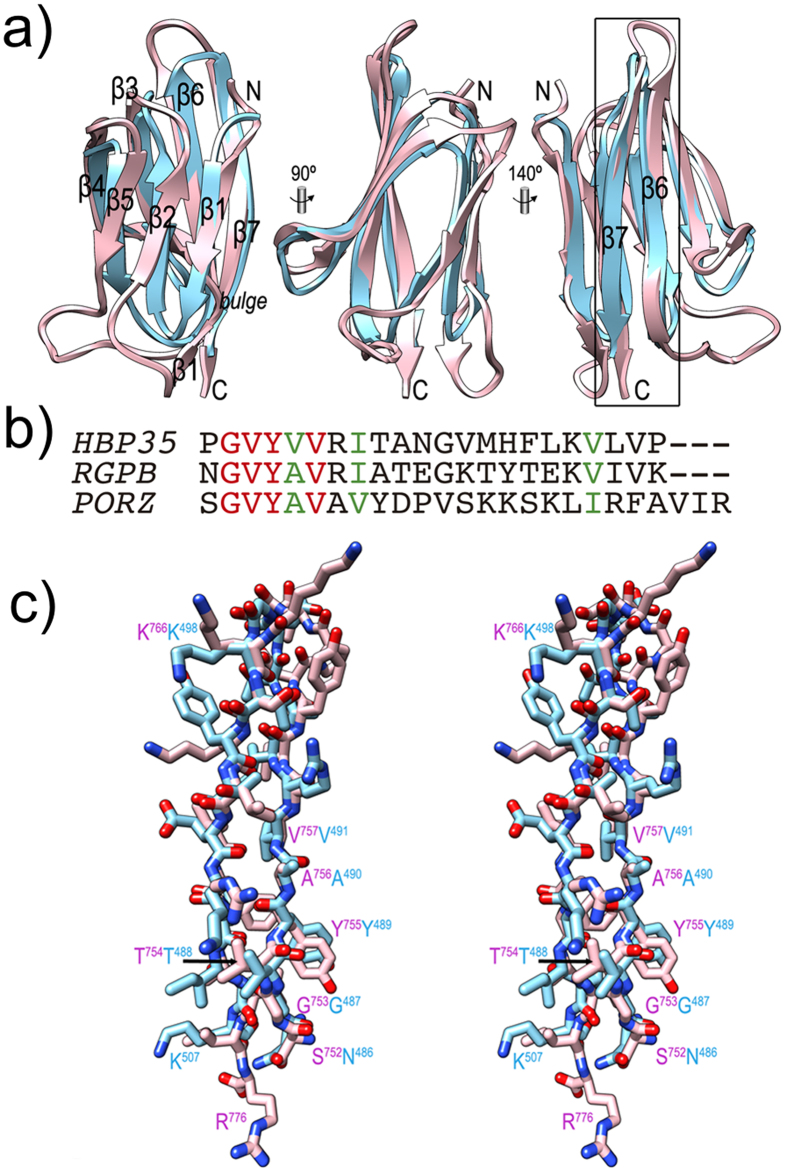
The C-terminal domain of PorZ.(a) Ribbon-plot of the CTDs of PorZ (pink) and RgpB (cyan) after optimal superposition facing the three-stranded front β-sheet (left, the seven constituting strands are labelled, see also Fig. 5b); after a vertical 90° rotation (center); and facing the four-stranded back β-sheet (right). C-terminal strands β6 and β7, which contain the reported molecular determinants for T9SS secretion1215, are framed and labeled in the right panel. (b) Sequence alignment of the 22 C-terminal residues of HBP35 (UniProt Q8G962) and RgpB (UniProt P95493), and the 25 final residues of PorZ after the structural alignment of the structures of the latter two proteins (see also [c]). Identical residues are in red, similar ones in green. G-X-Y sequences are also found in PKD proteins within strands equivalent to CTD-β6. These are also seven-stranded immunoglobulin-like all-β domains84, although the function of the G-X-Y motif therein is unknown. In addition, the Y_Y_Y domain of BT4663 protein contains this signature46. (c) Detail in cross-eye stereo showing the strands framed in (a) as full-atom models, i.e. segments S752—R776 of PorZ (with pink carbons and magenta labels) and N486—K507 of RgpB (mature protein numbering as subscripts, add 229 for full-length protein numbering; cyan carbons and labels).